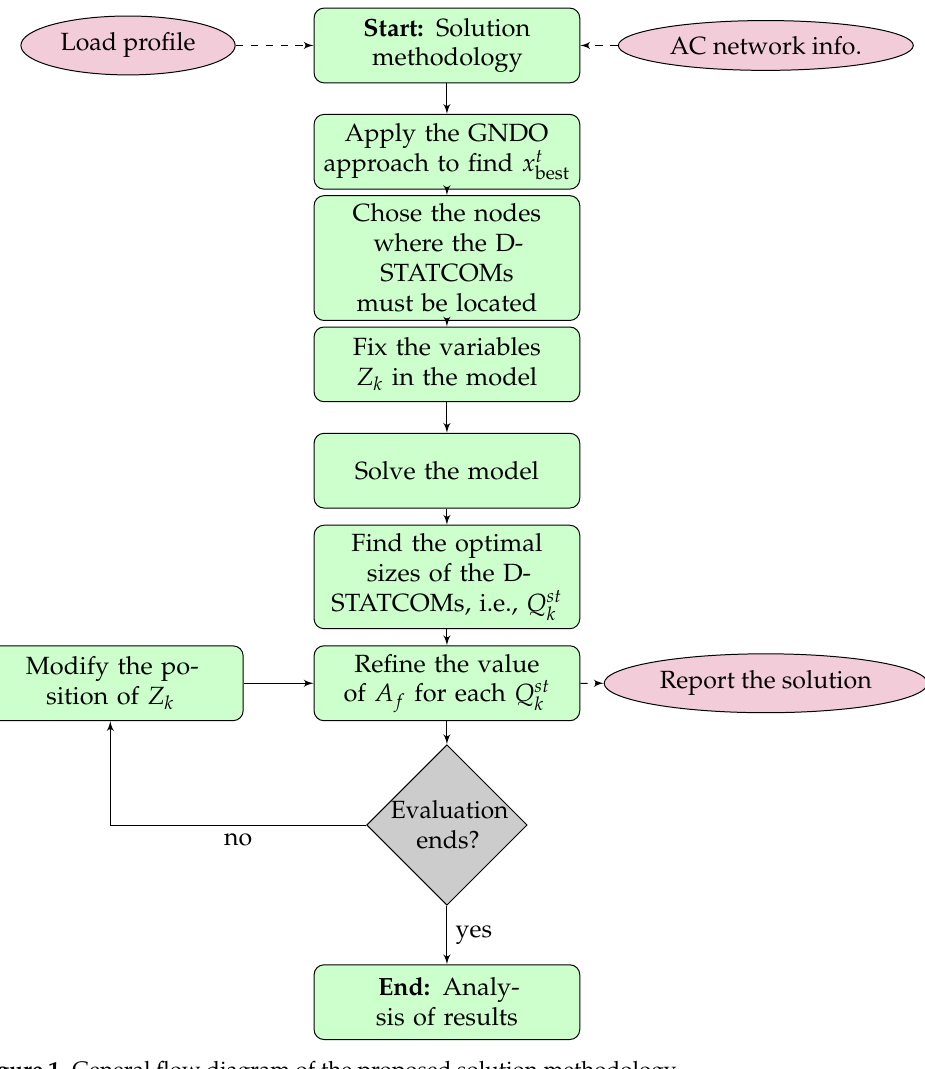
Figure 1. General flow diagram of the proposed solution